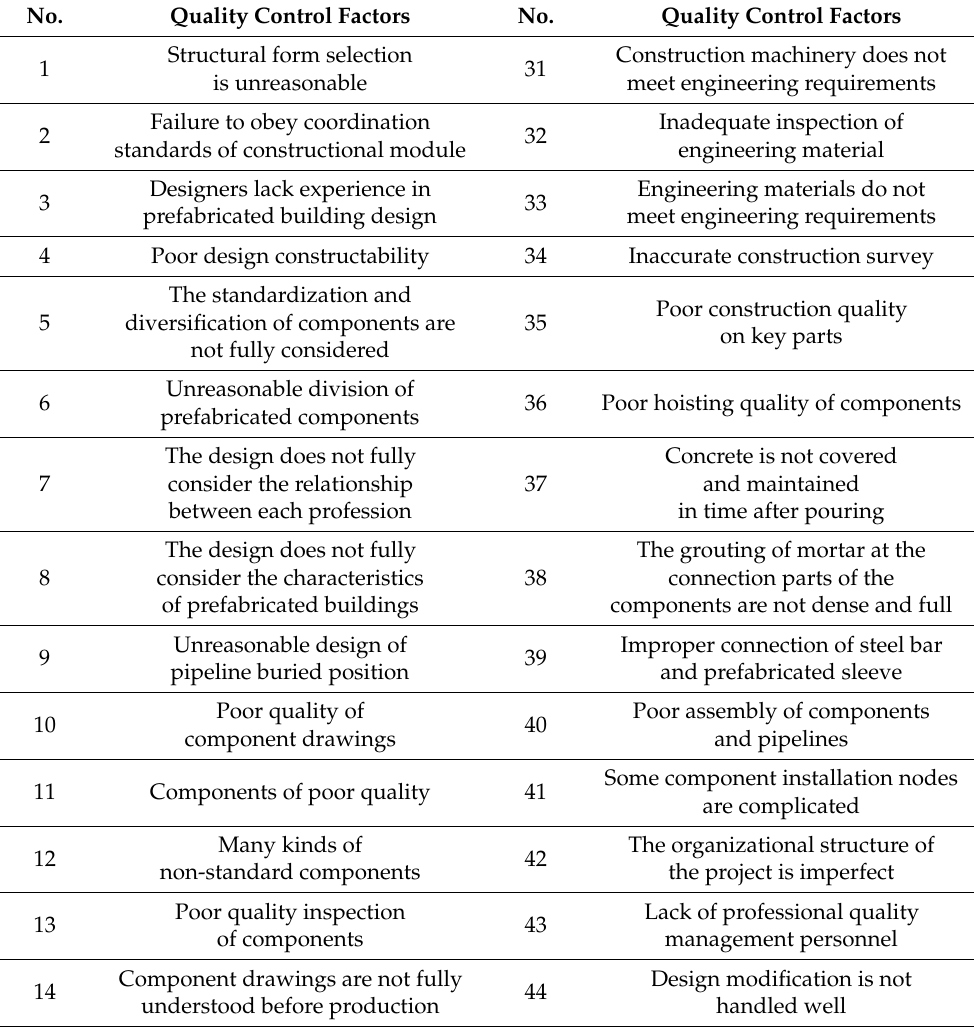
Table 1. Quality control